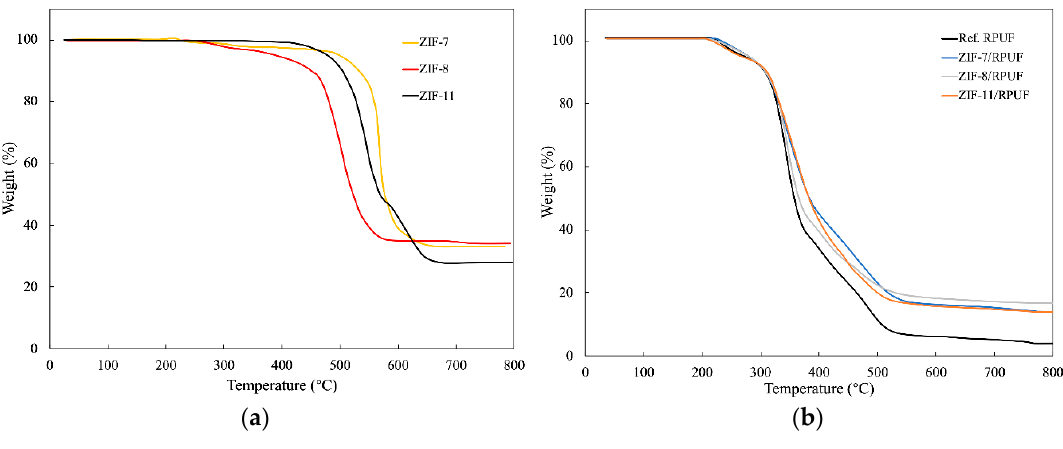
Figure 5. TGA curves of ZIFs ( a ) and ZIFs/RPUF ( b ).